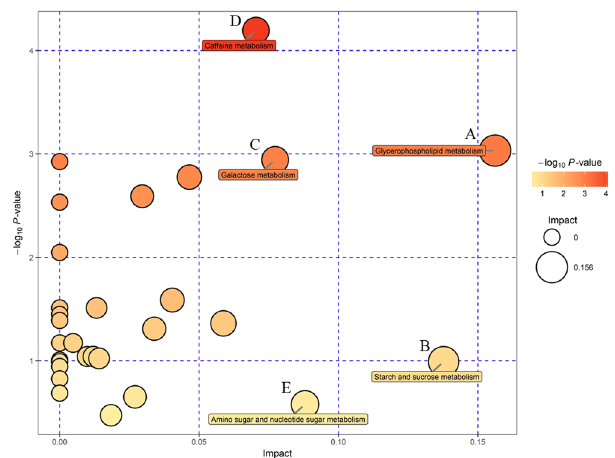
Figure 5. Summary of pathway analyses based on metabolomics data. ( A ) Glycerophospholipid metabolism. ( B ) Starch and sucrose metabolism. ( C ) Galactose metabolism. ( D ) Caffeine metabolism. ( E ) Amino sugar and nucleotide sugar